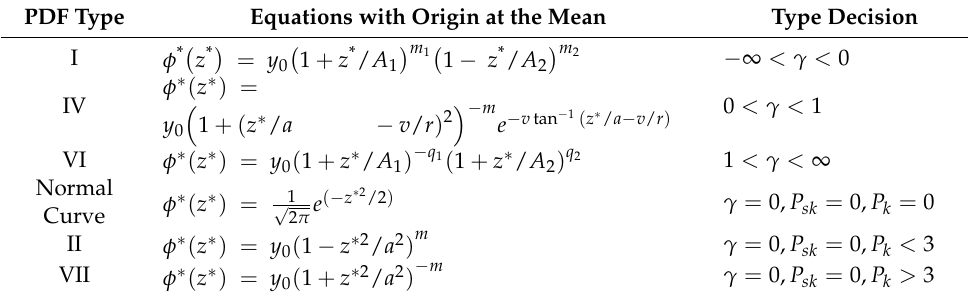
Table 1. Main PDF types of the Pearson distribution according to the parameter γ .